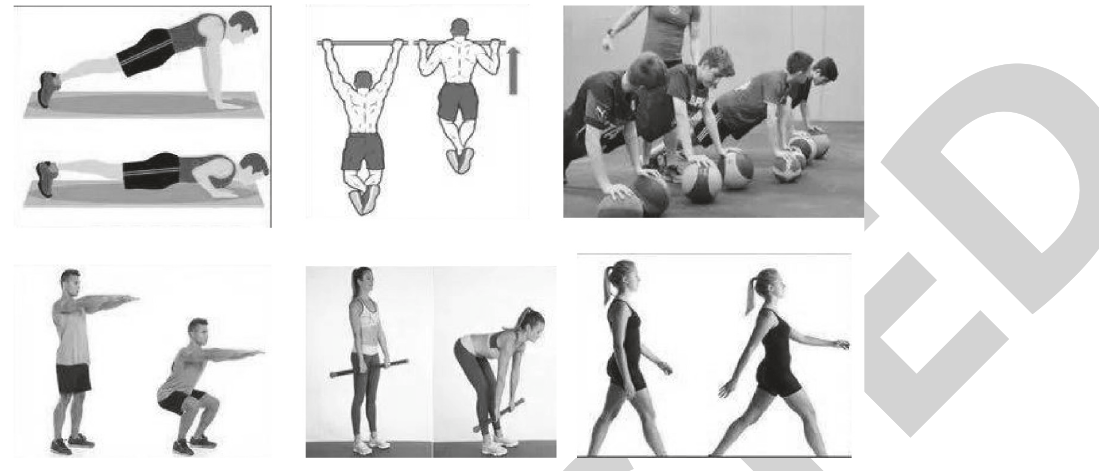
Figure 5: Entity diagram of normal human motion